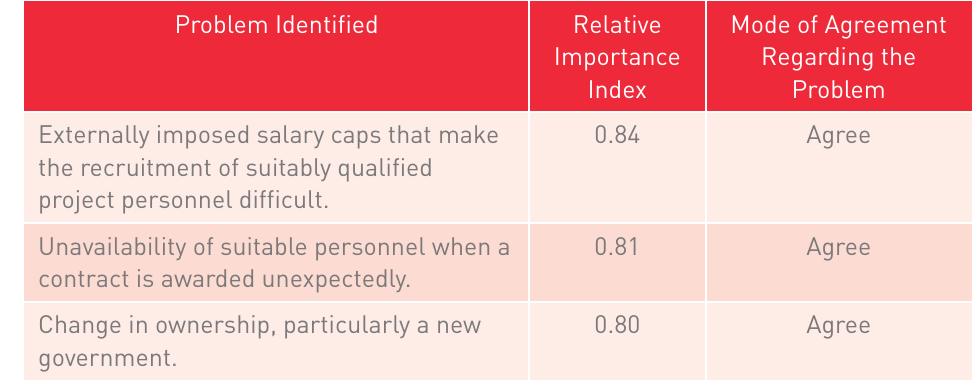
Additional project problems identified by panel